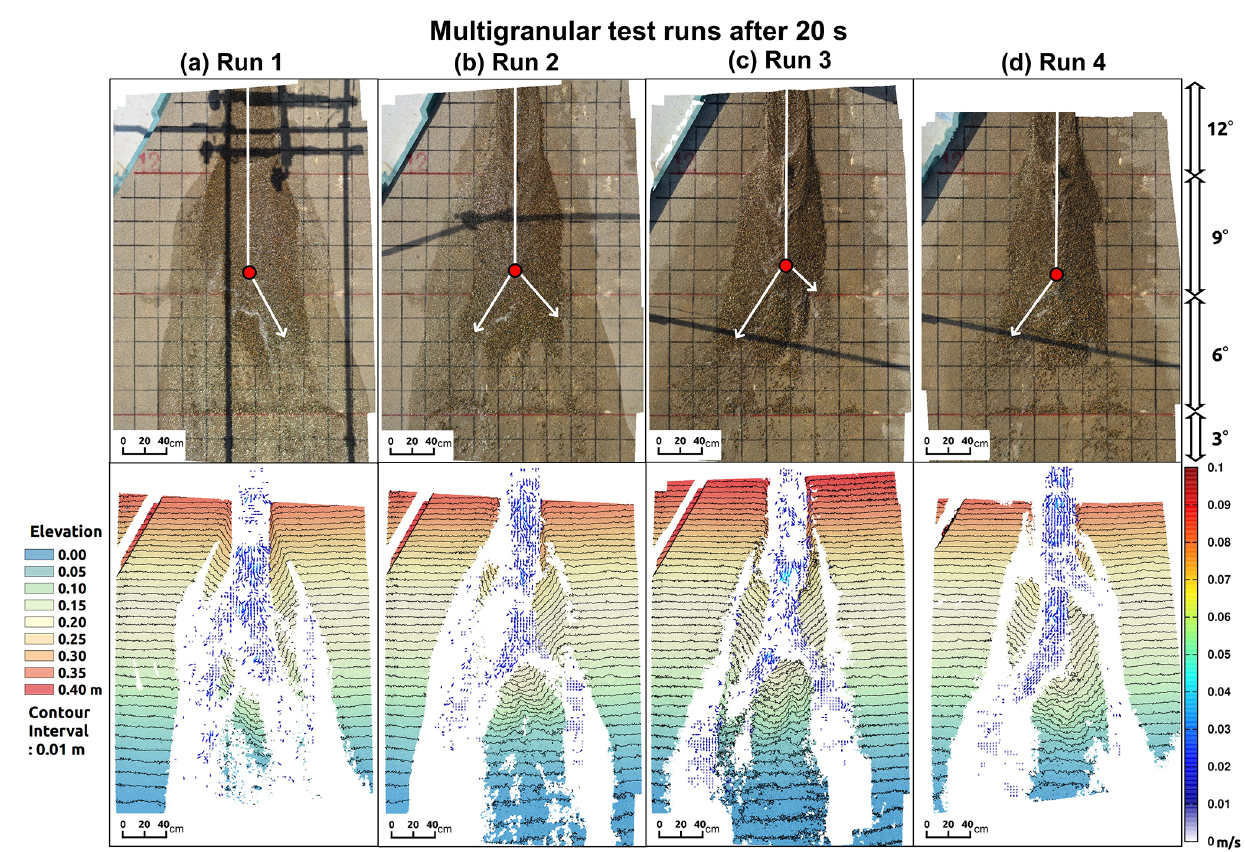
Figure 9. Fan morphology 20s after the start of runout of the multigranular flows. The upper and lower panels show orthophotos and digital elevation models (DEMs) with flow vectors, respectively. Respective sets of the upper orthophoto and lower DEM represent corresponding results of each experimental test run. The white arrows on the orthophotos indicate the assumed principal direction of flow descent. The red points in the orthophotos indicate the assumed occurrence point of the avulsion. The elevation of the DEMs is depicted assuming that the area with a 3 ◦ slope (i.e., the area furthest downstream from where the slope angle changed from a 6 to 3 ◦ slope) has elevation of